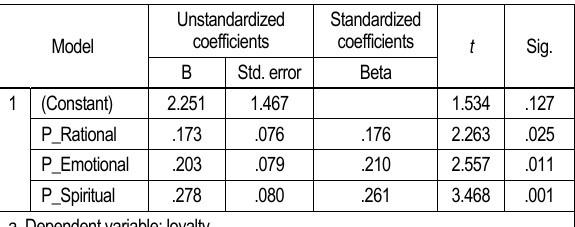
Table 7. Partial test ( t -test) of the third equation Unstandardized coefficients Model